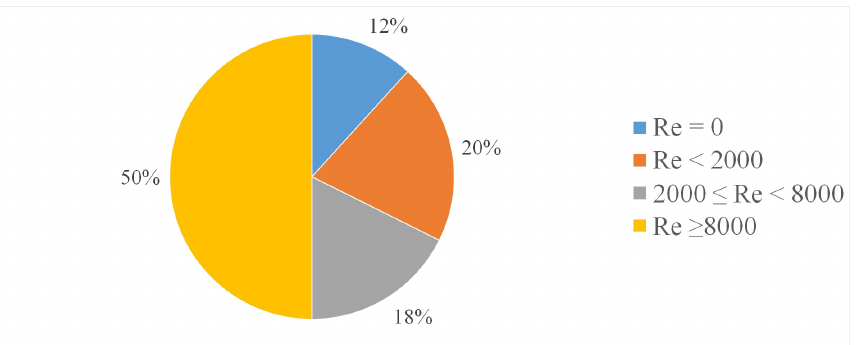
Figure 8. Category #4: pre-transient Reynolds number, Re . Percentages of the papers for the four ranges.